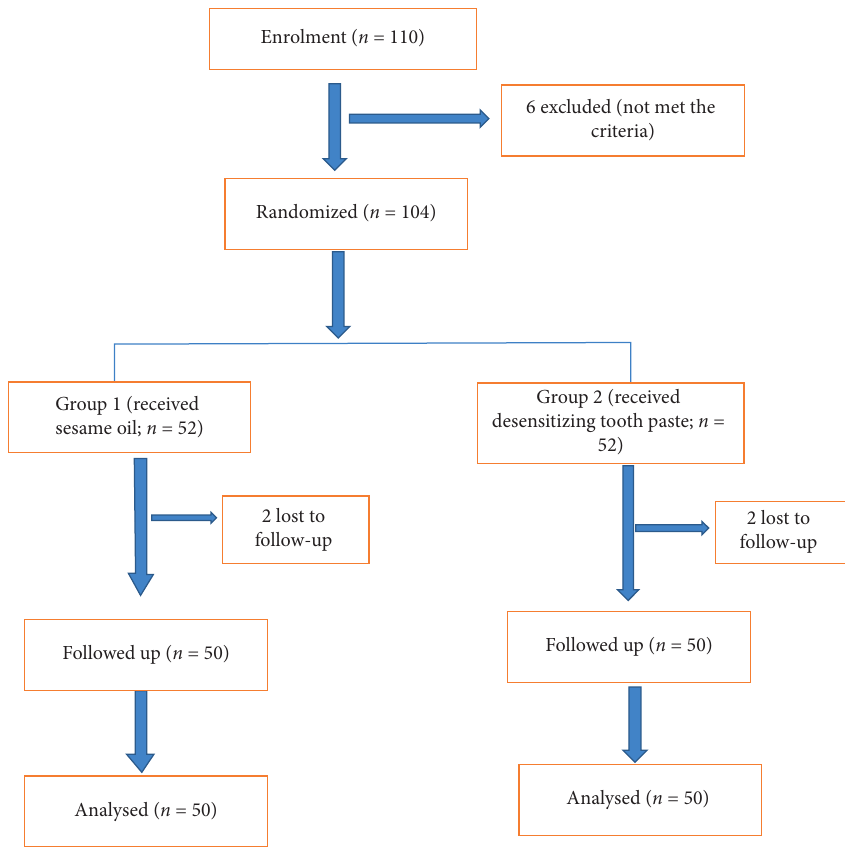
Figure 1: Randomization flow